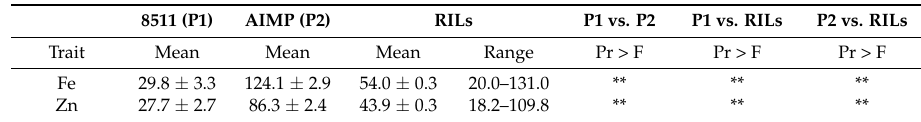
Table 2. Descriptive statistics of phenotypic values observed in RILs derived from the cross